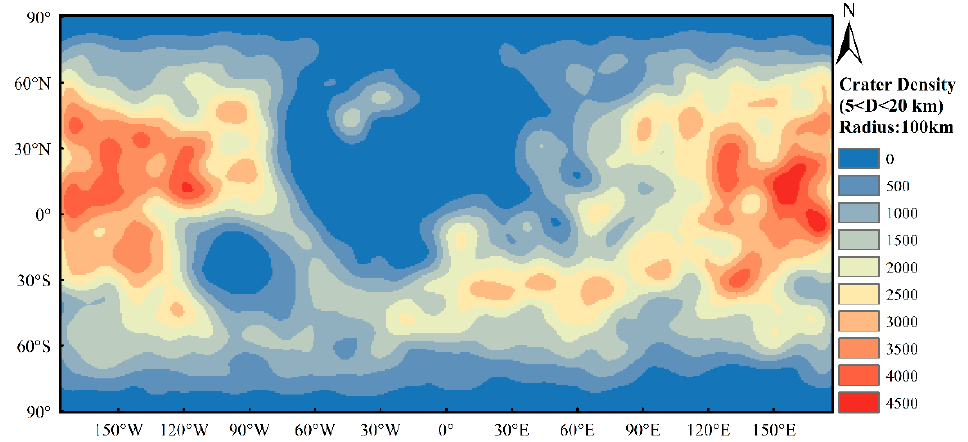
Figure 14. The density map of lunar impact craters (5 km < D < 20 km).